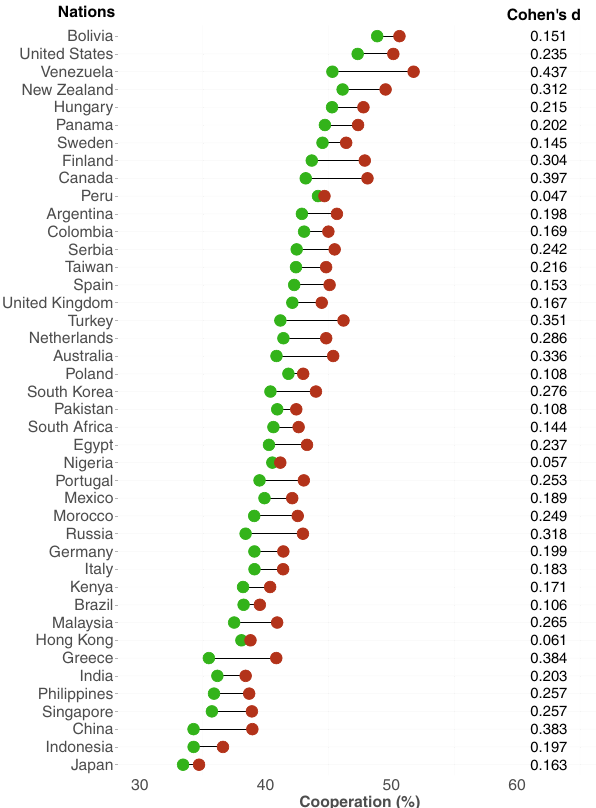
Fig. 1 National parochialism across nations. Cleveland dot plot showing the mean of cooperation (in percentage) with ingroup members (red dots) compared to outgroup members and unidenti fi ed strangers (green dots) across all the 12 decisions (including both the public and private treatments). Nations are sorted based on their average cooperation levels. The right-side column reports the estimated standardized mean difference (Cohen ’ s d c ) of national parochialism in cooperation. Source data are provided as a Source Data fi le.